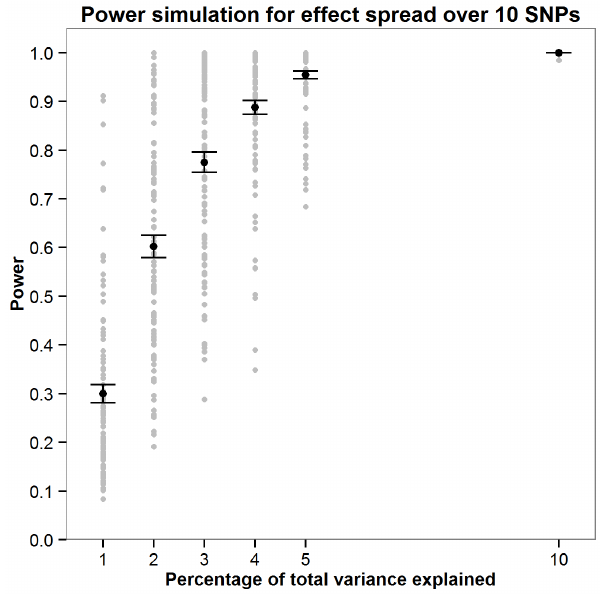
Figure 1. Simulations exploring how power fuctuates as a function of total variance explained when the effect is spread over 10 SNPs. For each effect size (1,2,3,4,5 or 10% of the total variance) 100 simulations were carried out. The mean power from these 100 simulations is shown in red with error bars depicting 6 1 standard error.